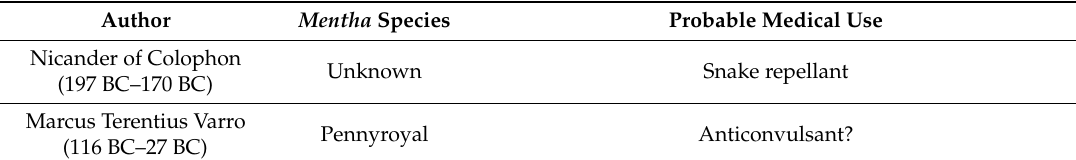
Table 1. Probable medical uses given to di ff erent Mentha species by the main authors discussed in this review throughout history in chronological